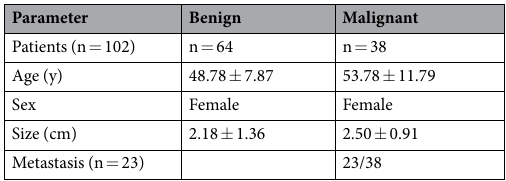
Table 4. Characteristics of patients and breast